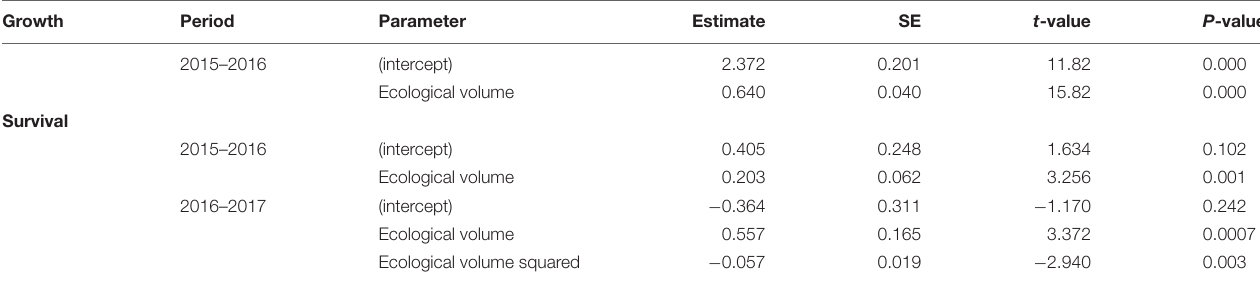
TABLE 2 | Best fit regression models for growth and survival. Growth